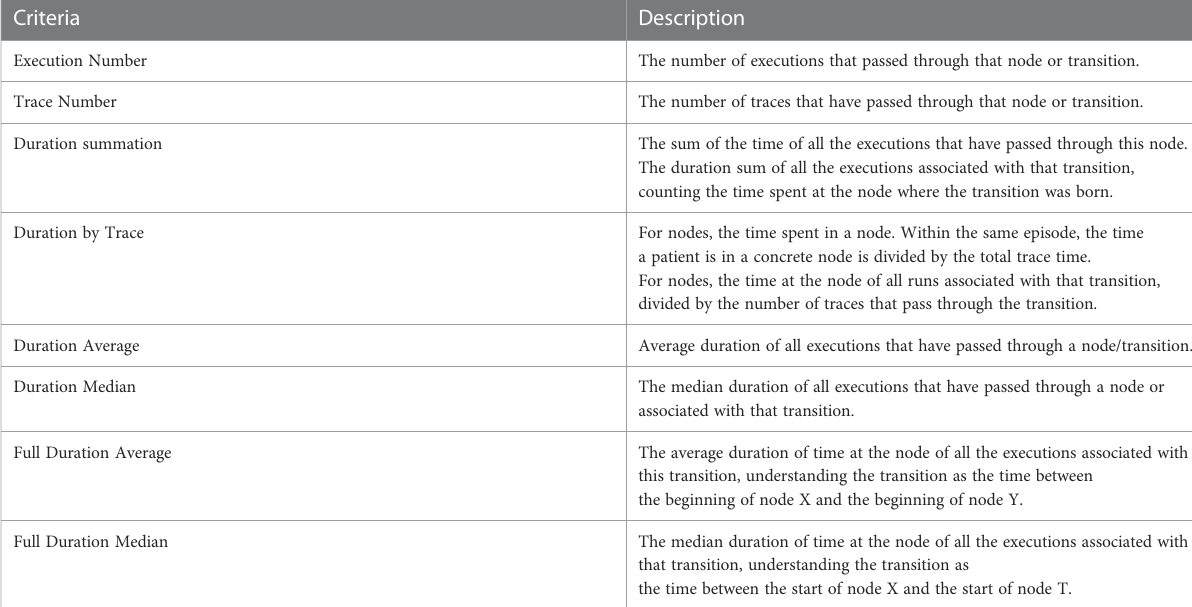
TABLE 4 Enhancements for nodes and transitions.